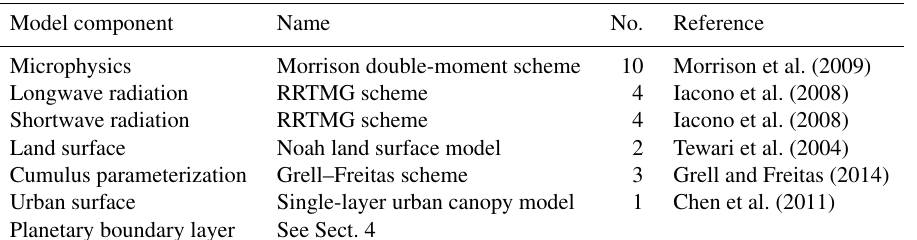
Table 1. List of WRF-Chem physical parameterizations adopted in this study. The number column refers to the parameterization choice as specified in the WRF-Chem model. Note: RRTMG is the Rapid Radiative Transfer Model for global climate models.